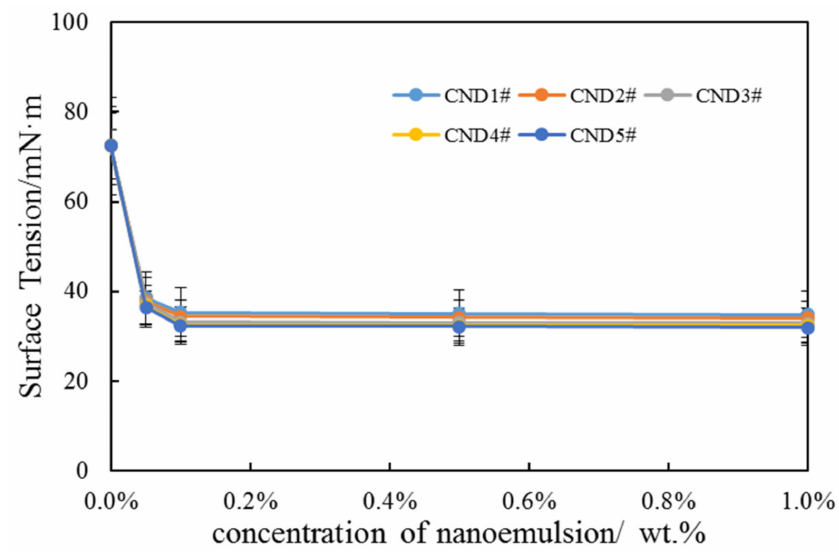
Figure 8. Surface tension curve with concentration of